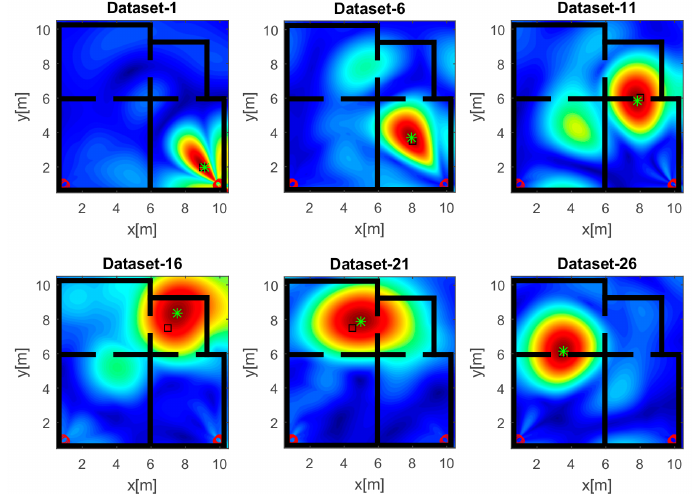
Figure 15. Tomographic images of a narrow band source achieved with additive-array image fusion (D). Arrays (red circles); true source position (black square); estimated source position (green asterisk). Color scale is [0, 1].